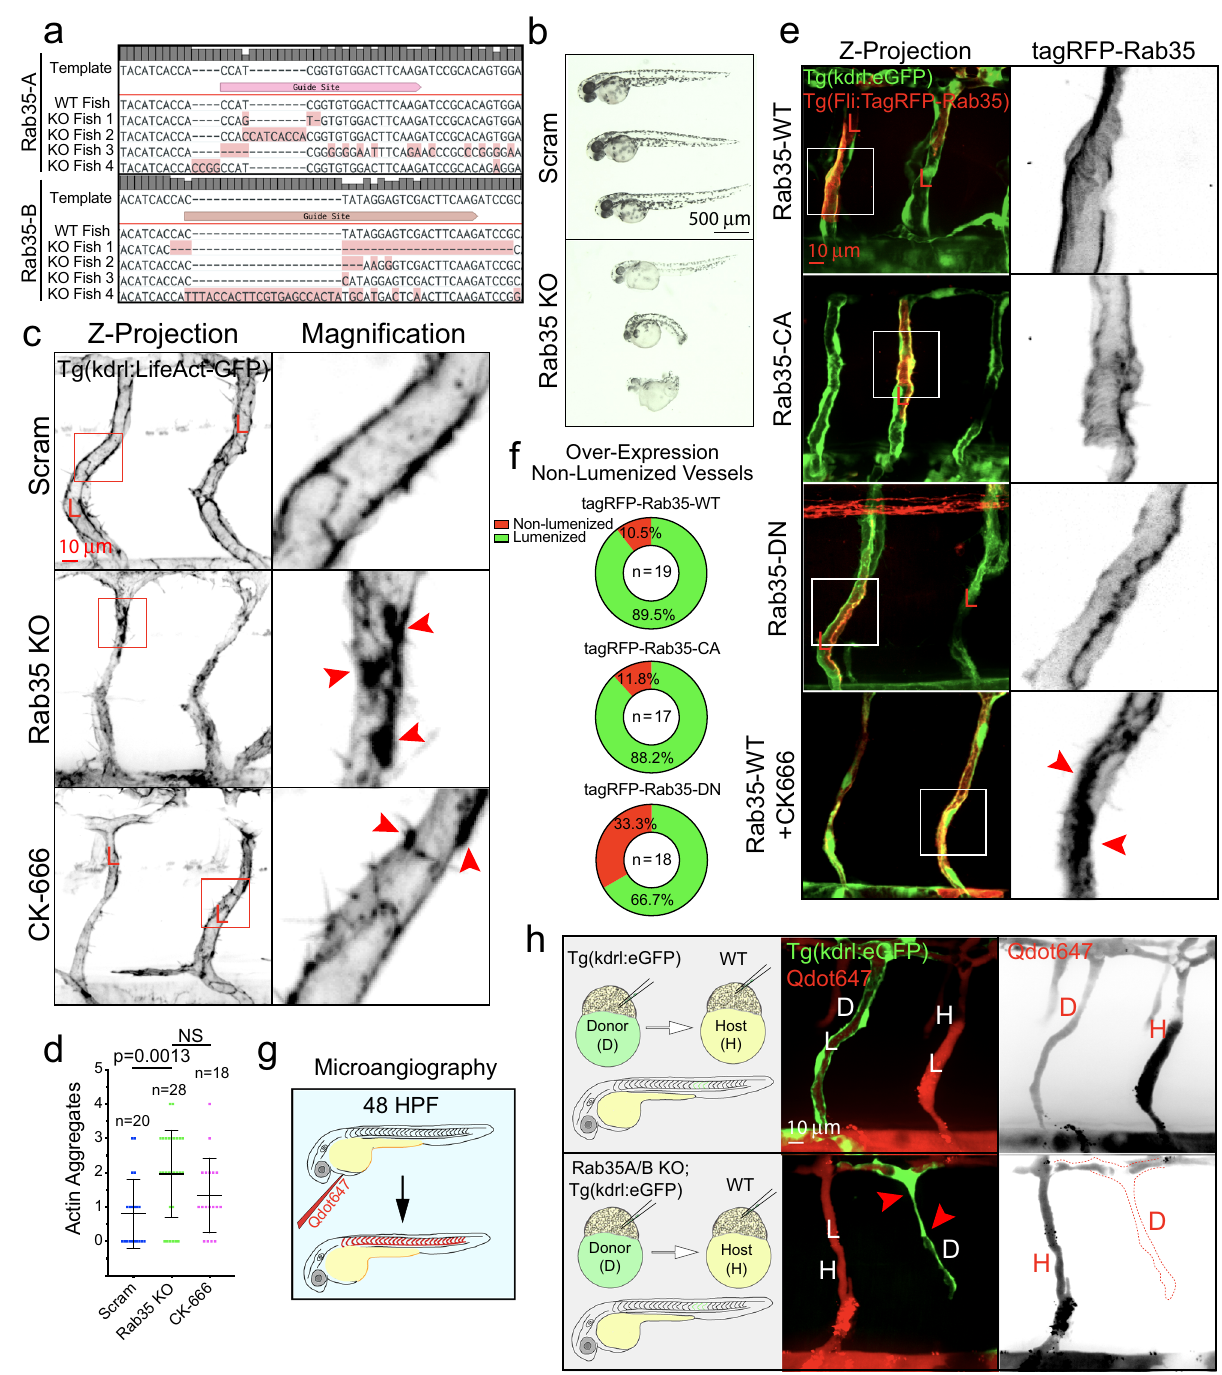
Fig. 9 | Rab35 is required for blood vessel development in zebra fi sh. a CRISPR- mediated knockout of Rab35A/B con fi rmation by sequencing. Four random fi sh were sequenced following CRISPR/guide injections. b Zebra fi sh morphology at 48h post fertilization (hpf) post injection of scramble (Scram) and Rab35A/B CRISPR guides. c Representative images of intersomitic blood vessels (ISVs) of Scram and Rab35A/B knockout, aswell asCK-666 (ArpInhibitor), treated zebra fi sh at 48 hpf expressing endothelial speci fi c LifeAct-GFP. Red arrowheads indicate abnormalaggregatesofactin. d Quanti fi cationofactinaggregatesbetweengroups. n =number ofISVs. A minimum of 5 fi sh wereused pergroup.Error bars represent standard deviation, middle bars are the mean. e Representative images of mosaic expression of Tag-RFP-Rab35 WT (top row), CA (second row), DN (third row), and WT with CK-666 treatment inzebra fi sh at48hpf.Red arrowheadsdepictexcess of